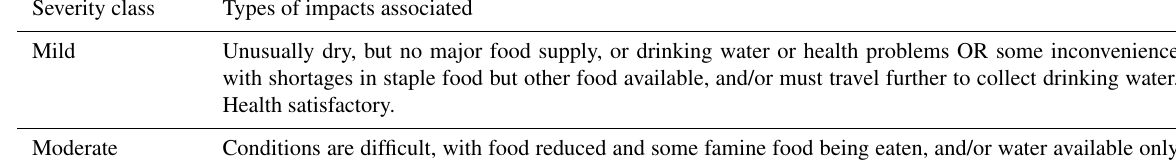
Table 5. Information on the types of impacts associated with the three severity classes used to classify drought severity in the literature. Adapted from Allen and Bourke (2009).